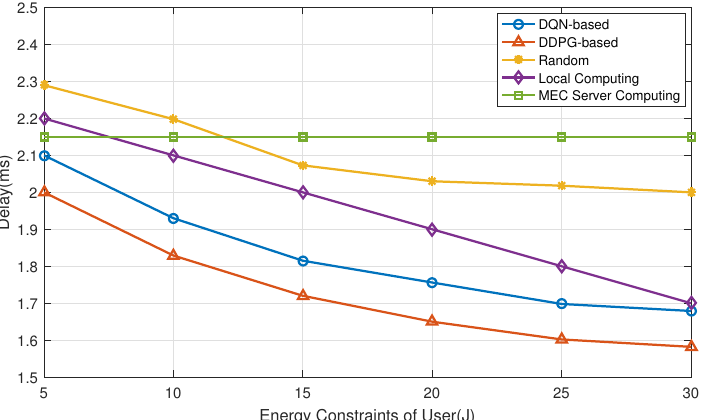
Figure 11. The delay comparison under different energy constraints at the intelligent terminals, where the red curve represents the delay of the DDPG-based computational offloading paradigm, the blue curve represents the delay of the DQN-based computational offloading paradigm, the yellow curve represents the delay of the “Random” policy, the purple curve represents the delay of the “Local computing” policy, and the green curve represents the delay of the “MEC server computing”